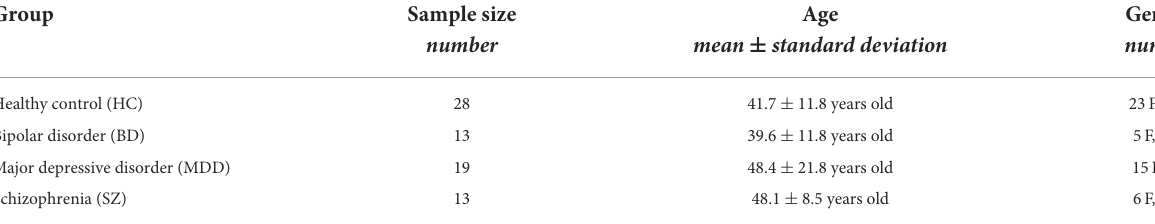
TABLE 1 Details of participants for the four groups involved in the study.